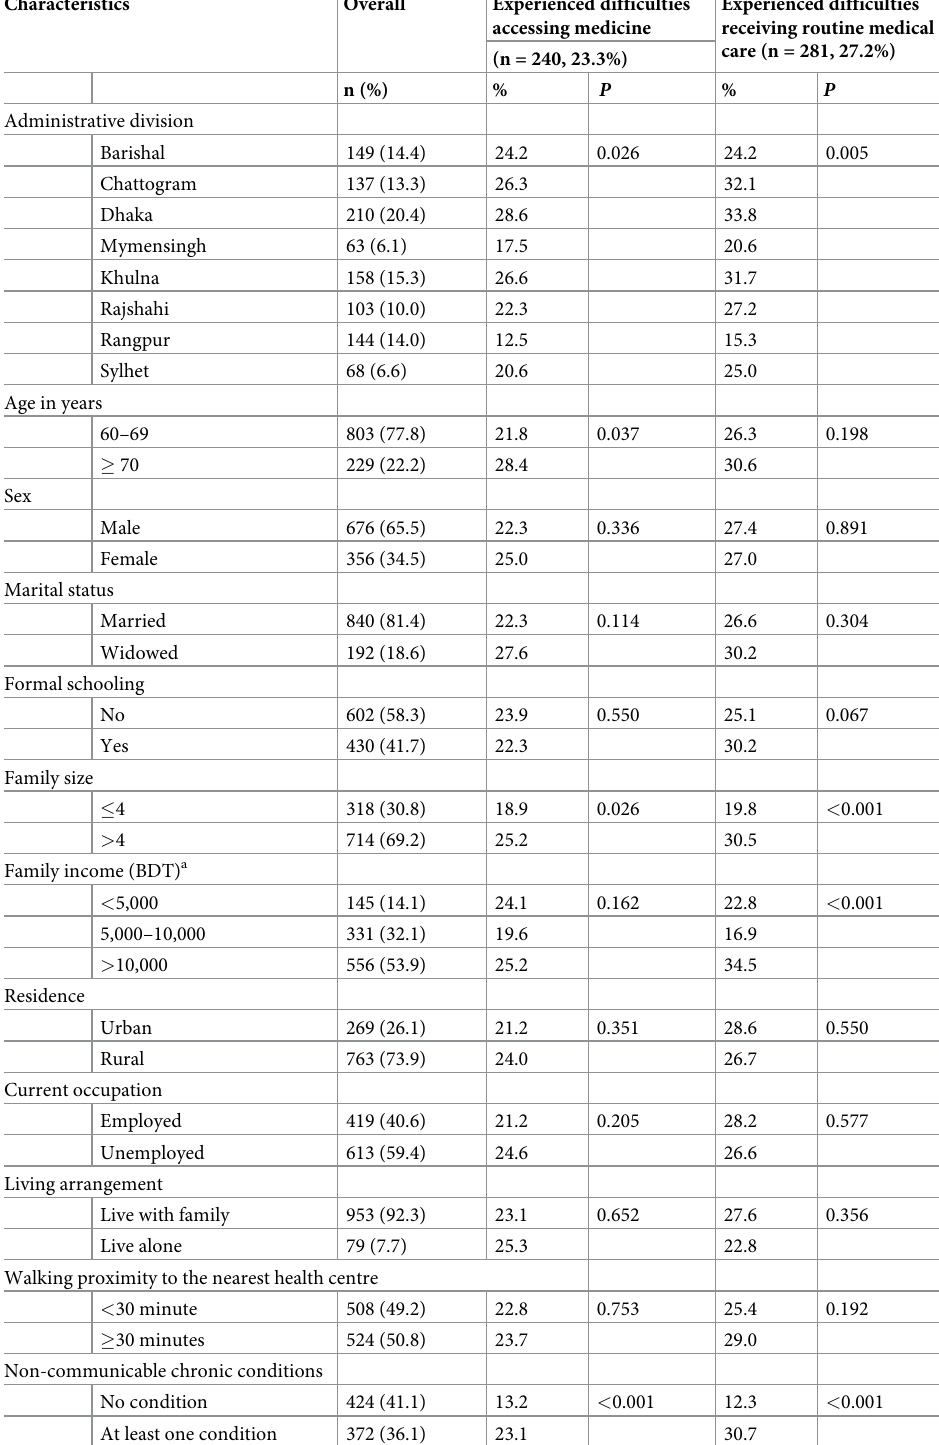
Table 2. Participants’ characteristics and bivariate analysis (N = 1032).